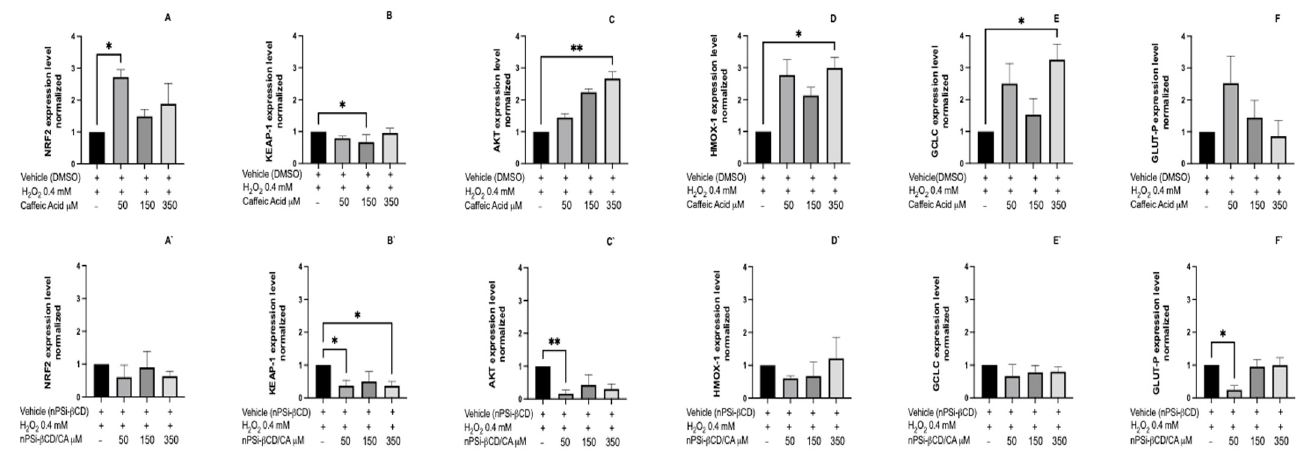
Figure 9. Effect of treatment with caffeic acid on the expression of genes related to the antioxidant pathway. HUVECs were stimulated with 0.4 mM H 2 O 2 and treated with caffeic acid at concentrations of 50, 150, and 350 μ M for 8 h. ( A – F ): Treatments with caffeic acid in solution. ( A` – F` ): treatments with caffeic acid loaded in the nPSi- β CD composite microparticle. The data were normalized against RPL-30 and GAPDH. The bars represent the mean expression for each group ± standard deviation. The number of asterisks reflects differences between control (vehicle) vs. treatments (* = p < 0.05; ** = p < 0.01; n = 3).